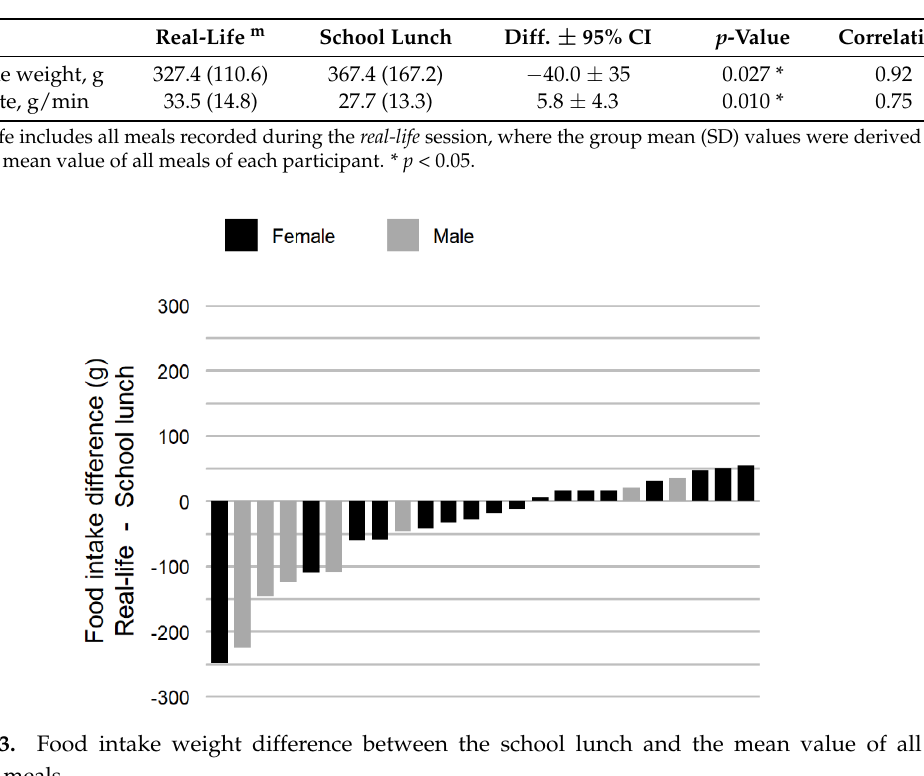
Table 2. Mean (SD) values of food intake weight and eating rate of recorded meals.